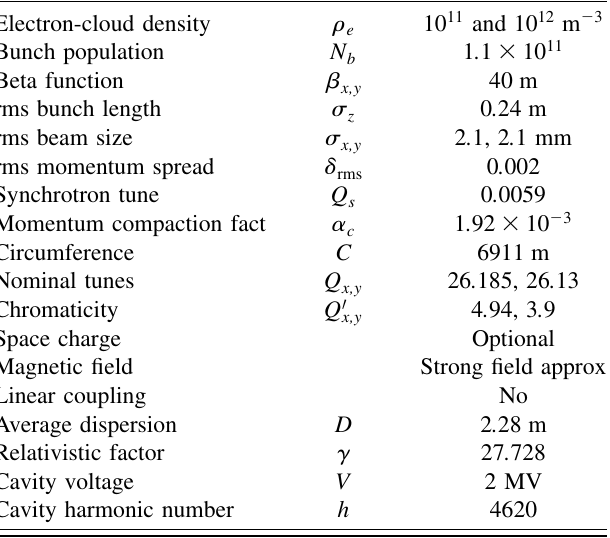
TABLE III. Parameters used in the simulations for LHC-type beam in SPS at injection.